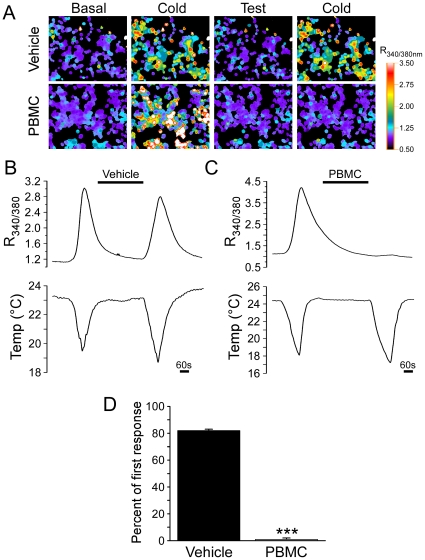
PBMC inhibits cold-evoked TRPM8 responses.
A) Representative images of HEK293T cells expressing mTRPM8. Pseudocolored images of the 340/380 nm Fura-2 ratio (R340/380) show low basal Ca2+ before cooling the bath solution, which evoked a robust increase in intracellular Ca2+. After treating the cells for five minutes with vehicle (top row) or 25 nM PBMC (bottom row), cells again displayed low basal Ca2+ levels. A second cooling of the bath resulted in a calcium increase in vehicle, but not PBMC-treated cells. B) Average changes in the R340/380 of vehicle-washed cold-responding cells show that, under these conditions, the second cold pulse resulted in a robust influx of calcium into the intracellular space which was only slightly smaller than that seen for the first cold pulse. C) Average changes in the R340/380 of cells washed with PBMC show that the drug abolished the second calcium influx. D) 25 nM PBMC significantly inhibited cold responses in HEK293T cells transfected with TRPM8 as compared with vehicle controls. Data are presented as the average value of the second response as a percentage of the first compared for vehicle- (black bars; 82.0±1.0) and PBMC- (grey bars; 0.4±0.4) treated cells (Student's t-test, ***p<0.001).